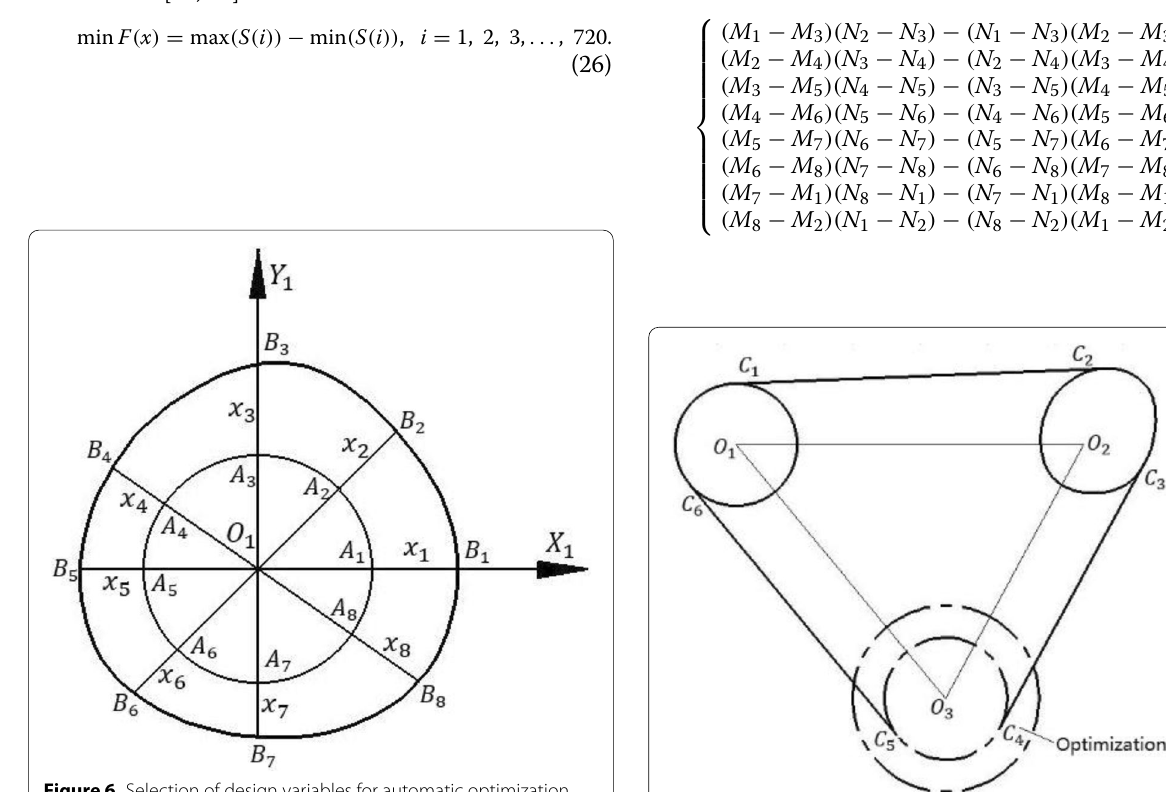
Figure 6 Selection of design variables for automatic optimization algorithm Figure 7 Schematic of search area of automatic search